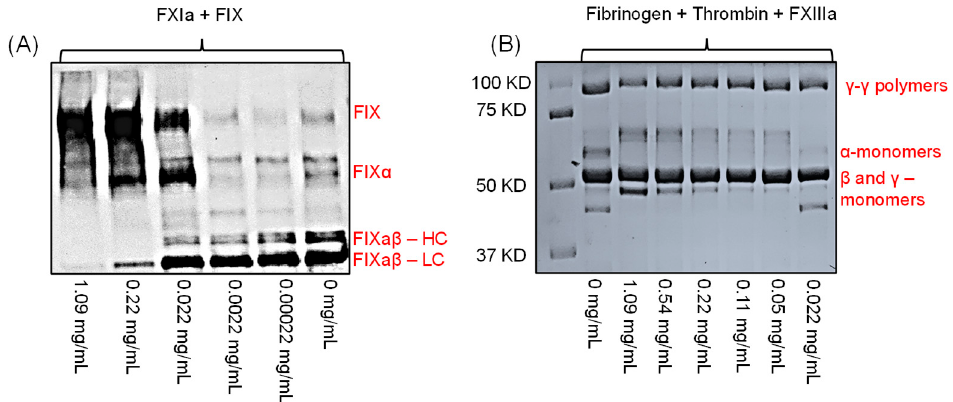
Figure 5. ( A ) Effect of LSAS on FXIa-mediated activation of FIX using Western blotting under reducing conditions. LSAS concentrations used were 0, 0.00022, 0.0022, 0.022, 0.22, and 1.09 mg/mL. Shown is activation of FIX to FIX α then to FIXa β by cleaving the peptide bonds, Arg145–Ala146 and Arg180–Val181, respectively. FIXa β appears as two bands: one band for the heavy chain (FIXa β –HC) and the other band for the light chain (FIXa β –LC), under reducing conditions. ( B ) Effect of LSAS on FXIIIa-mediated fibrin crosslinking as evaluated by SDS-PAGE under reducing conditions. Results indicate